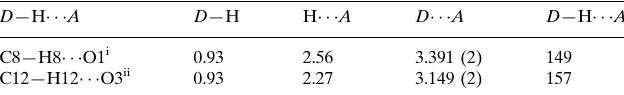
Hydrogen-bond geometry (A˚ , (cid:2)